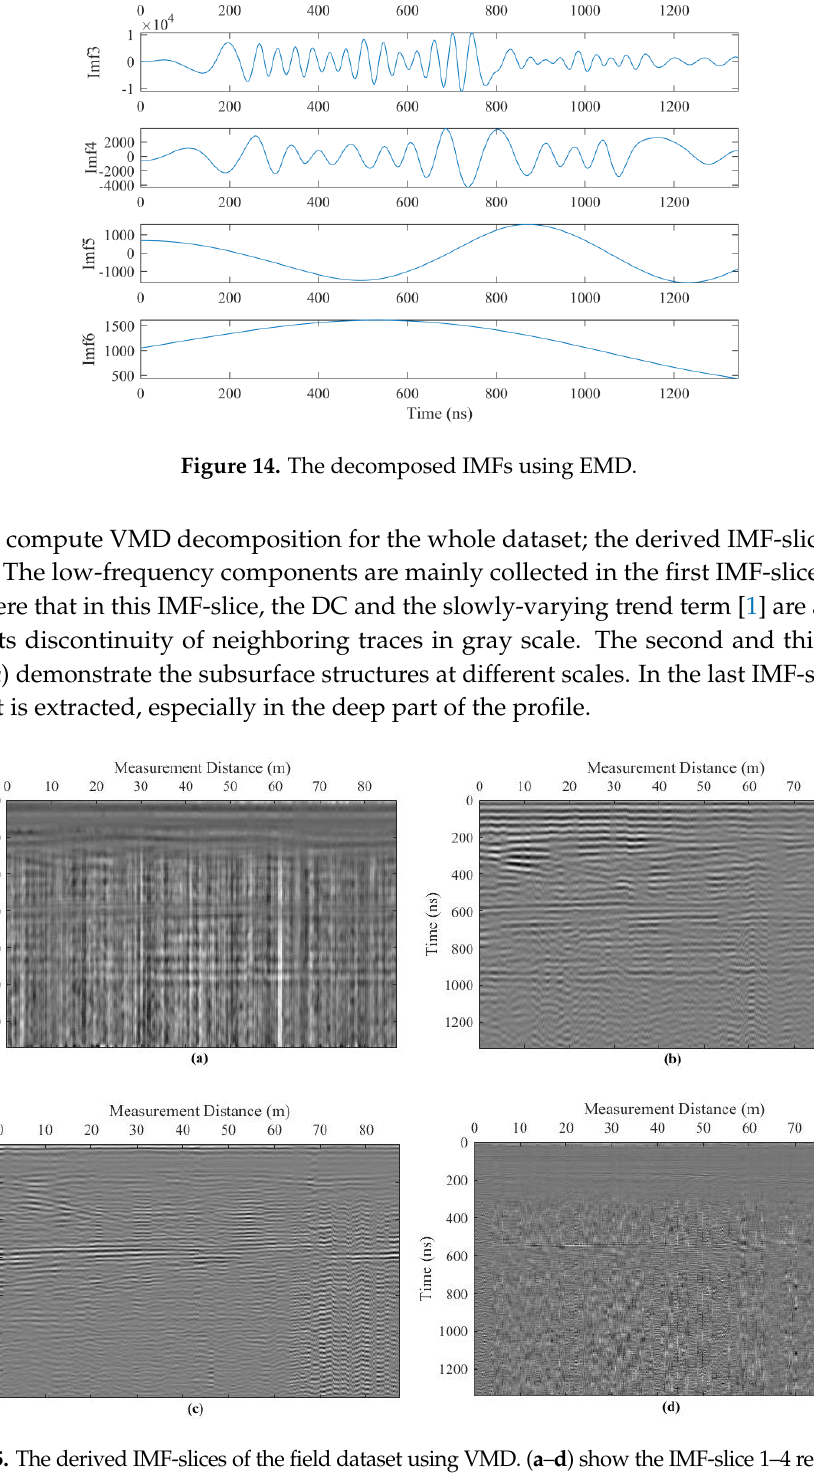
Figure 16. The derived IMF-slices of the field dataset using EMD. ( a – d ) show the IMF-slice 1–4 respectively. 5. Conclusions